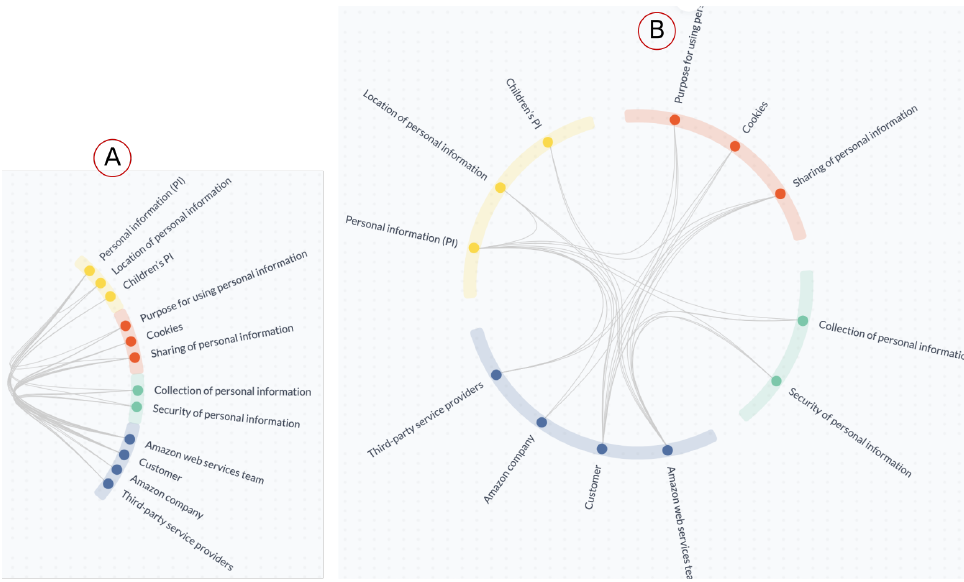
Figure 8. Sub-circle ( A ) from total circle ( B ) visual